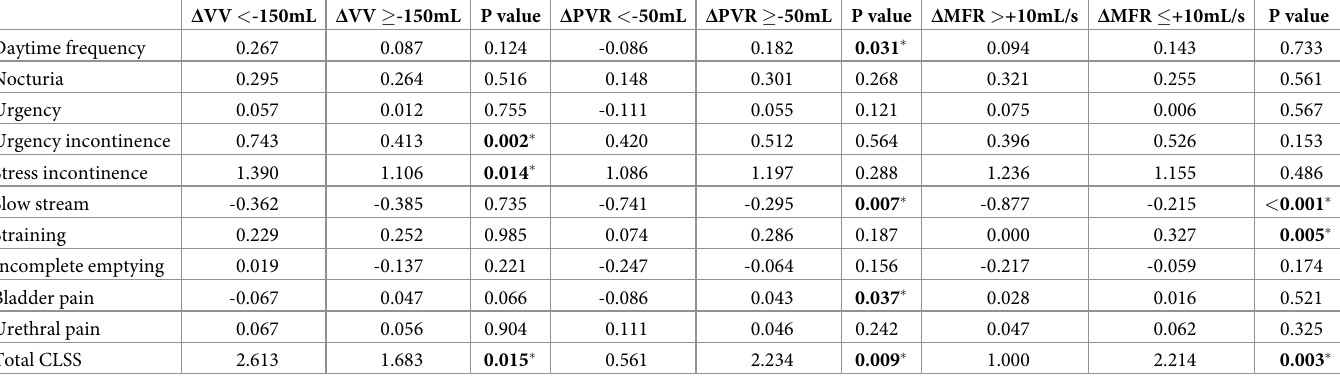
Table 4. Perioperative changes in CLSS questionnaire results stratified by uroflowmetry parameter changes.